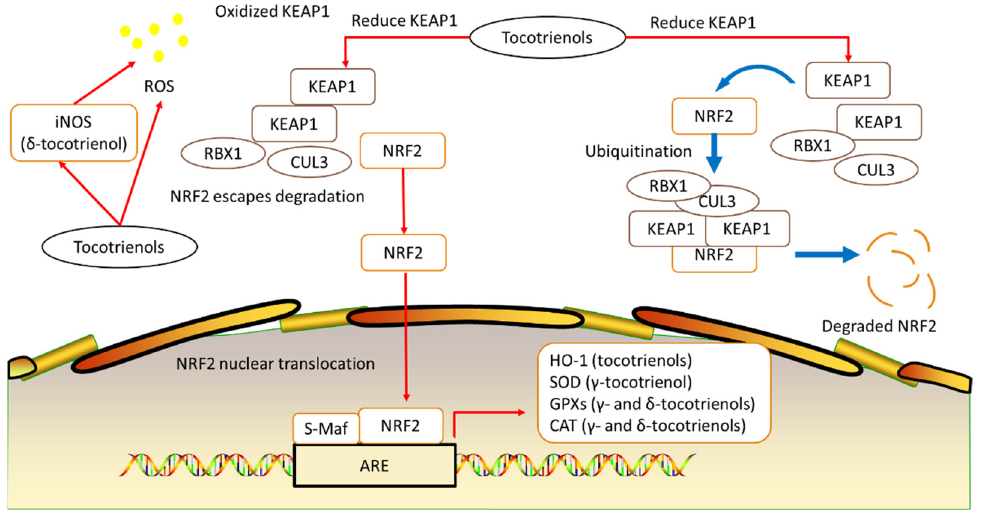
Figure 3. NRF2-KEAP1-AREs signaling pathway and the effects of tocotrienols.